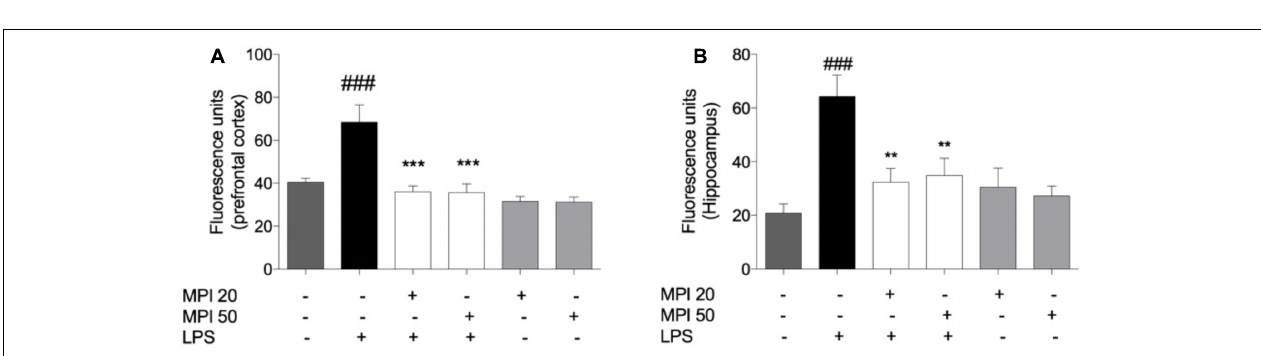
FIGURE 4 | Effect of MPI on lipid peroxidation in LPS-challenged mice. After 24 h of LPS administration, the LPS-induced group had significantly increased the TBARS levels in PFC (A) and HC (B) ### P < 0.001 when compared to the control group. MPI followed by LPS administration prevented the increase of TBARS levels in PFC ( F 5 , 30 = 35.47, P < 0.001, post hoc ∗∗∗ P < 0.001, n = 6) and HC ( F 5 , 30 = 26.18, P < 0.001, post hoc ∗∗∗ P < 0.001, n = 6) ( ∗∗∗ ) when compared to the LPS-induced group. No significant differences observed among the control and MPI followed by saline admnistration. Data were analyzed using a one-way ANOVA followed by the Student–Newman–Keuls multiple comparisons post hoc test. Error bars represent SEM.